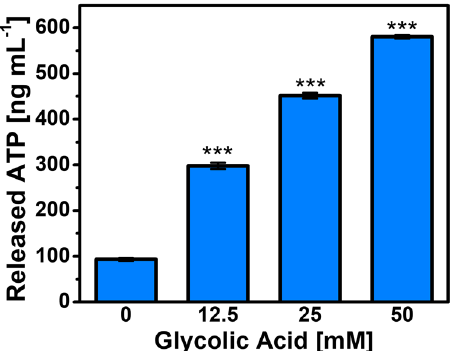
Figure 4. Effect of glycolic acid treatment on bacterial cell membrane integrity. The concentration of extracellular ATP released from C. acnes cells was measured by bioluminescence assay. The C. acnes cell concentration was 2 × 10 8 CFU mL − 1 . Mean ± standard deviation values are reported from n = 3